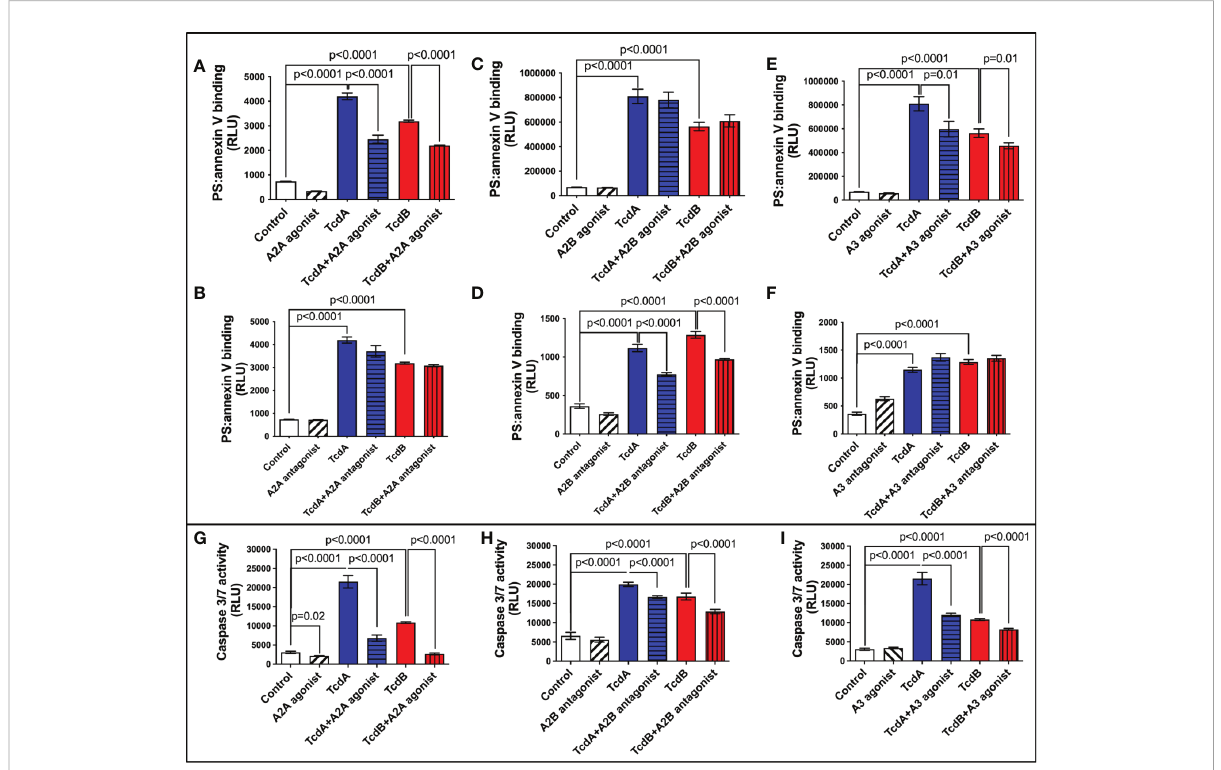
FIGURE 2 Modulation of adenosine receptors decrease EGCs death induced by C. dif fi cile toxins. (A – F) Cell death analyzed by RealTime-Glo annexin V apoptosis assay (mean ± s.e.m, n=6) in enteroglial cell (EGC/PK060399) challenged with TcdA and TcdB for 18 h in the presence or absence of (A) 300 µM ATL313 (an A2a-selective adenosine receptor agonist), (B) 3 µM SCH58261 (an A2a-selective adenosine receptor antagonist), (C) 1 µM BAY60-6583 (an A2b-selective adenosine receptor agonist), (D) 100 µM ATL801 (an A2b-selective adenosine receptor antagonist), (E) 30 µM CI-IBMECA (an A3AR-selective adenosine receptor agonist), and (F) 0.01 µM MRS1220 (an A3AR-selective adenosine receptor antagonist) added one hour prior to C . dif fi cile toxin challenge. (G – I) Activity of caspase 3/7 analyzed by luminescence assay (mean ± s.e.m, n=6) in enteroglial cell (EGC/PK060399) challenged with TcdA and TcdB for 18 h in the presence or absence of (G) 300 µM ATL313, (H) 100 µM ATL801 and (I) 30 µM CI-IBMECA added one hour prior to C . dif fi cile toxin challenge. (A – I) One-way ANOVA followed by Turkey test was used. These experiments are from two different